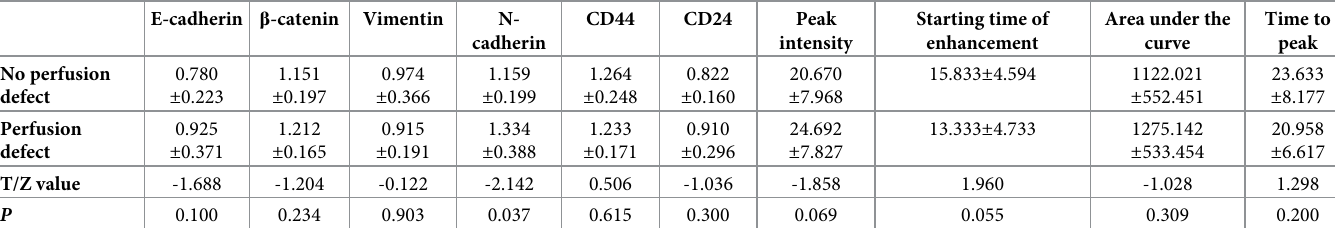
Table 3. Correlation between perfusion defect after breast cancer imaging and relative expression of CSC- and EMT-related genes. E-cadherin β -catenin Vimentin